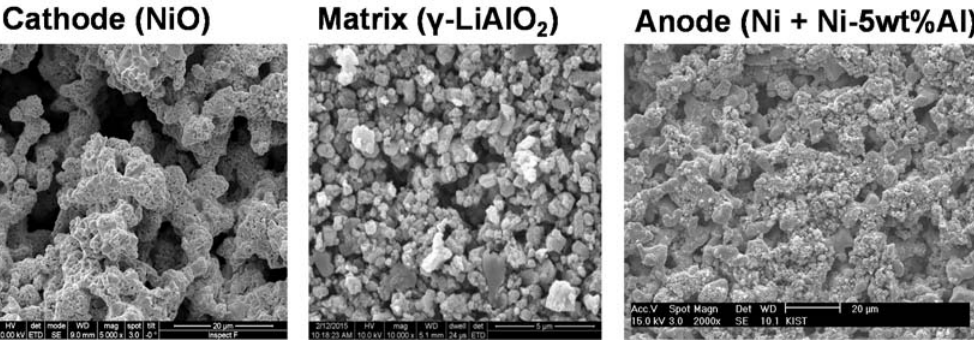
+ Ni-5wt% Al 2 matrix, and a Ni